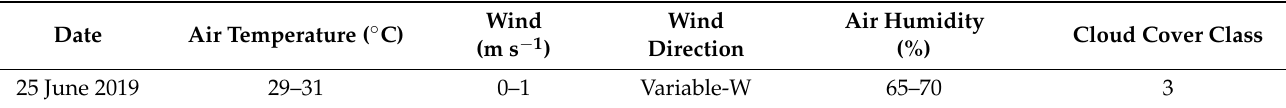
Table 3. Climatic conditions during the measurement.